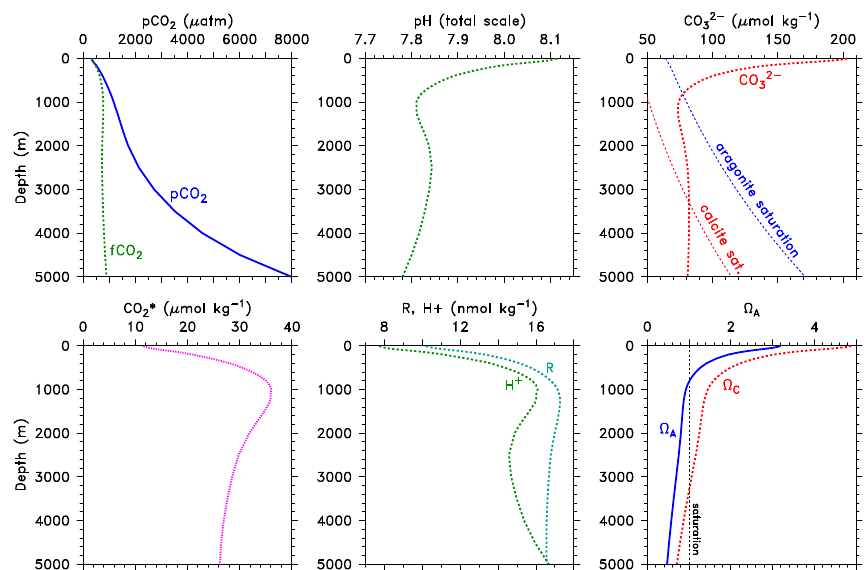
Figure 3. Global-mean vertical profiles of carbonate system variables computed with mocsy 2.0 from the data described in Fig.